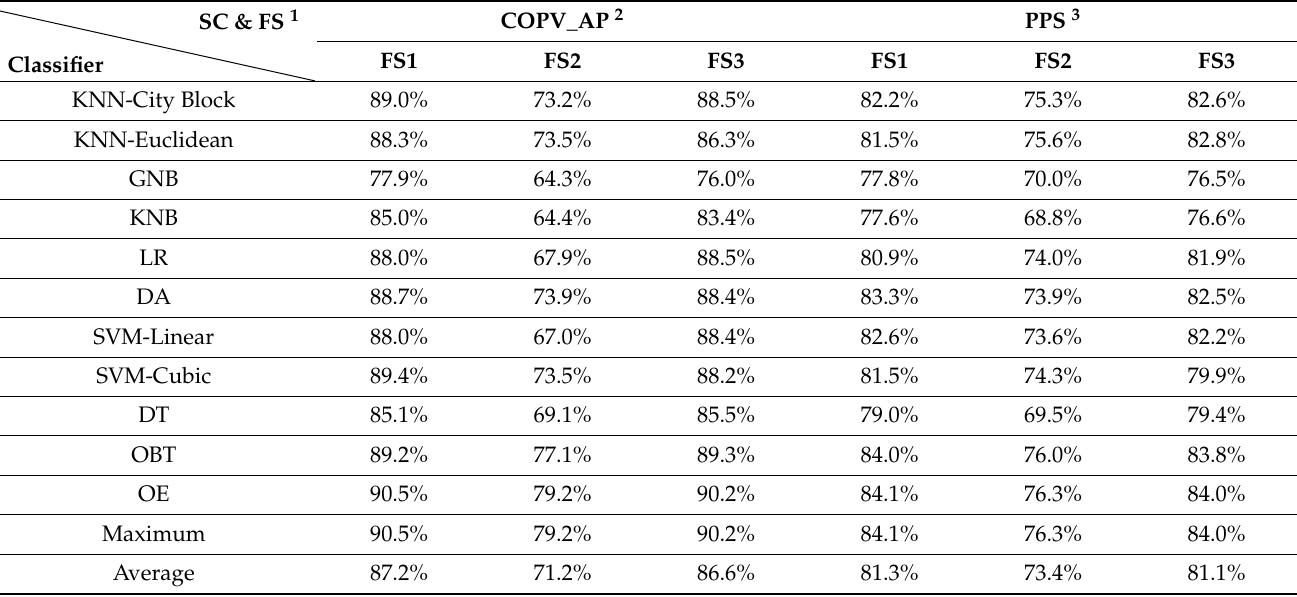
Table 7. Classification accuracies for different feature sets using different classifiers based on Pelvis acceleration